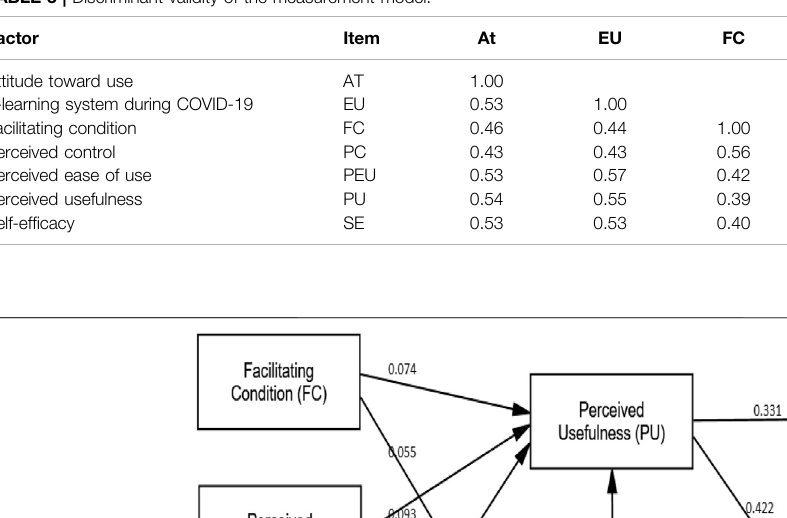
TABLE 3 | Discriminant validity of the measurement model.